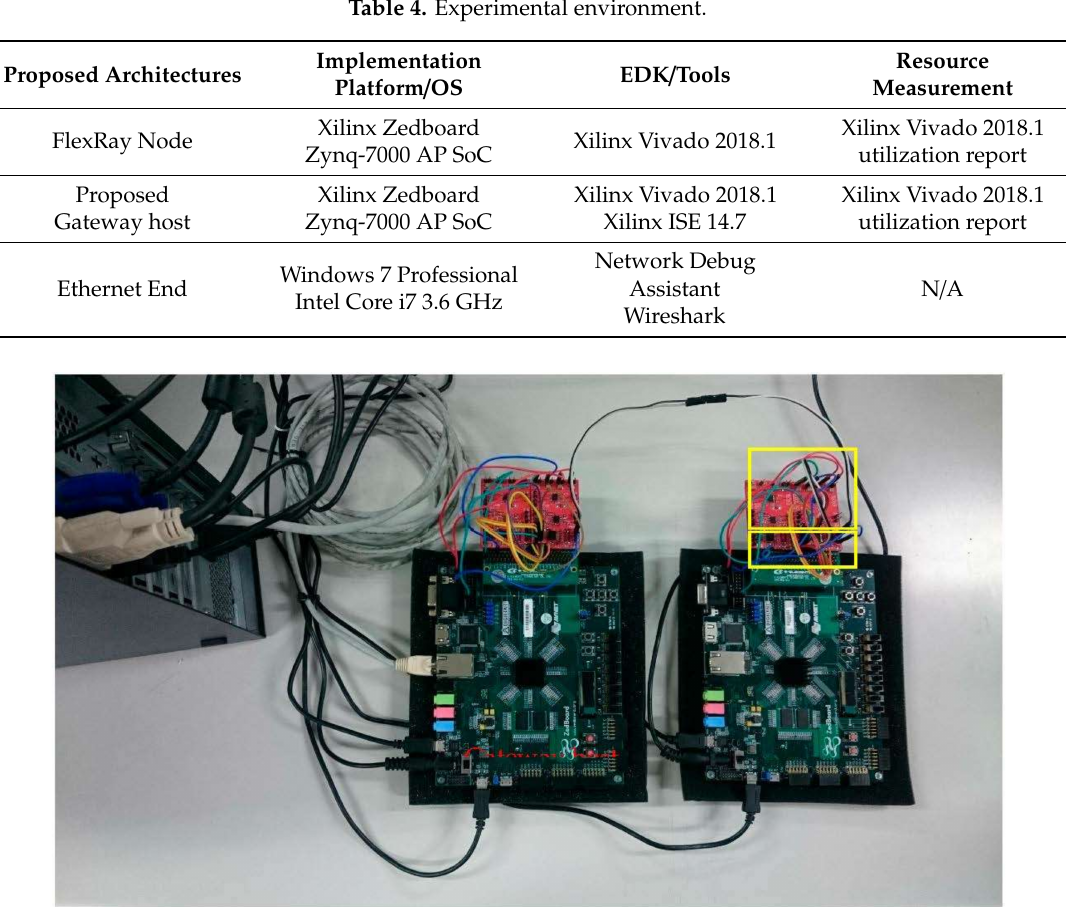
Figure 8. Overview of the hardware platform